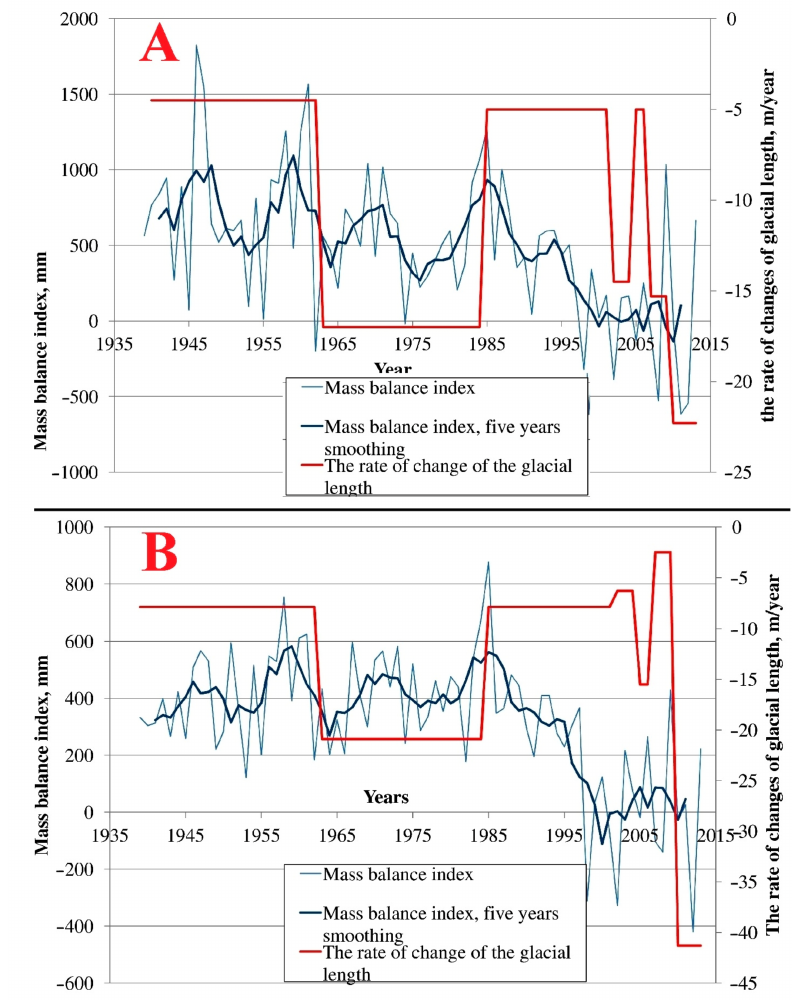
Figure 16. Mass balance index (mm w.e.) curves of Argamgi-3 Glacier ( A ) and Argamgi-2 Glacier ( B ) for the firn line altitudes (3150 m and 3380 m, respectively); smoothed (over 5-year intervals) mass balance index curves mm w.e.; the average rate of changes in the length of the glaciers, m year − 1